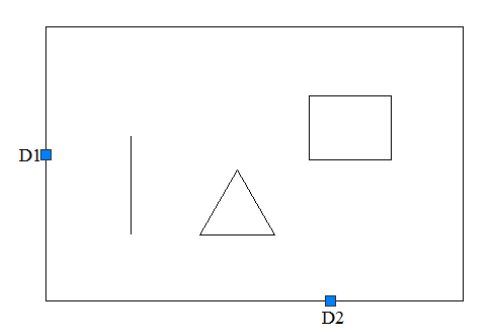
Figure 2. Simplified plan of Room A